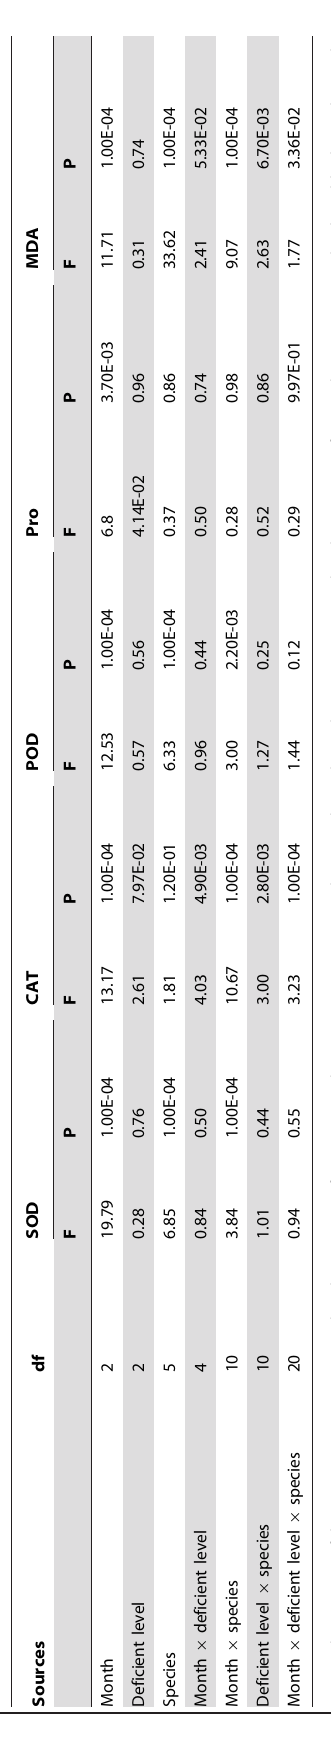
Figure 3. POD activities of six successional seral species. The measurements were conducted on July (7), August (8) and September (9) under three water deficient levels (severe, moderate and mild). Significant multi-comparison results of month 6 species and species were marked on the first and second X-axes’ label rows. And significant multi-comparison results of month were marked as a legend within a block (see associated ANOVAs results of Table 1).